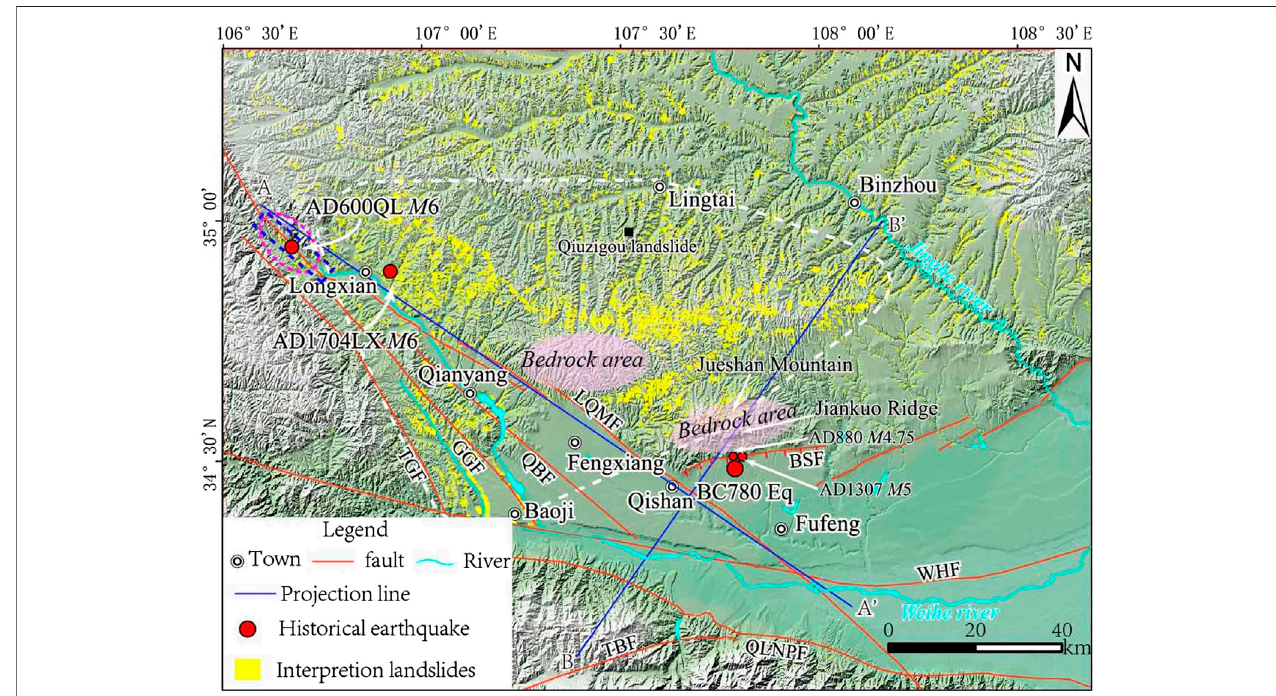
FIGURE 2 | Interpreted historical landslide distribution map at the Southwest of Ordos. LQMF: Longxian – Qishan – Mazhao Fault; QBF: Qianyang – Biaojiao Fault; GGF: Guguan – Guozhen Fault; TGF: Taoyuan-Guichuansi Fault; QLNPF: Qinling North Margin Fault; TBF: Taibai Mountain Fault; WHF: Weihe Fault; and BSF: Beishan PiedmontFault.Thepurpledashed ovalareaistheextreme earthquakezoneoftheAD600Qinlongearthquake(Wang,2018);thebluedashed rectanglerepresentsthe surface rupture of the AD 600 Qinlong earthquake along the Longxian – Qishan – Mazhao fault of the Dazhuangke – Dengjiacao section (Li et al., 2019); the area denoted by the white dotted line is the dense landslide area; and projection lines A – A ′ and B – B ′ correspond to Figure 4 .